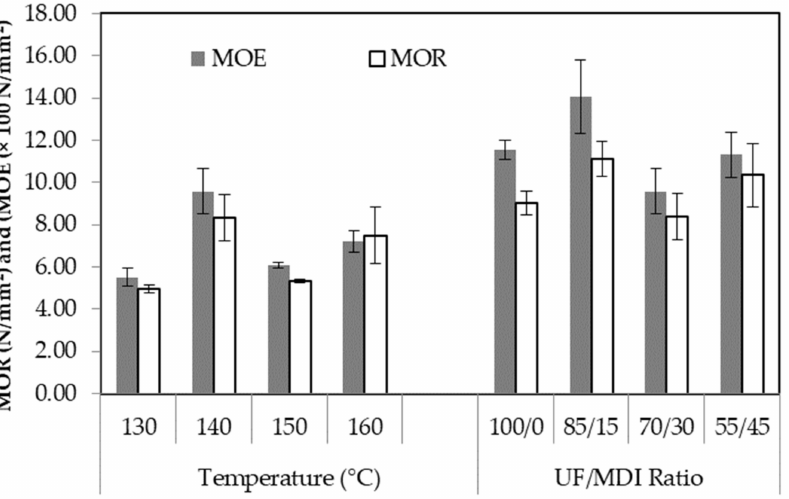
Figure 7. Modulus of rupture of the particleboard. The bars indicate the standard